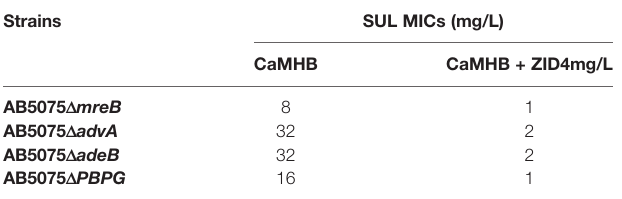
TABLE 2 | Sulbactam MICs against A. baumannii knockout strains using cation- adjusted Mueller – Hinton broth with and without zidebactam supplementation.